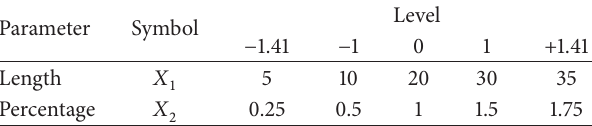
Table 2: Coding of the input parameters.